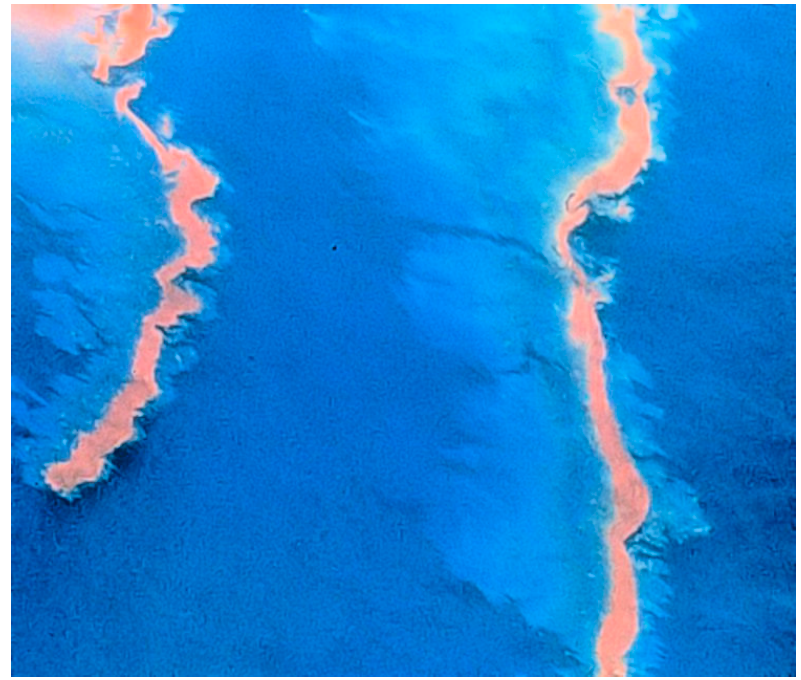
Figure 6. Photograph showing emulsion streaks surround by sheen (thin oil). This photograph was taken from an aircraft flying at about 1000 m.